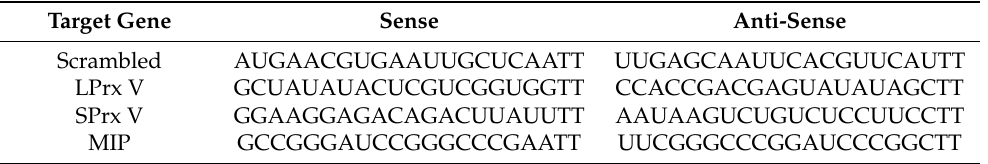
Table 2. Sequence of